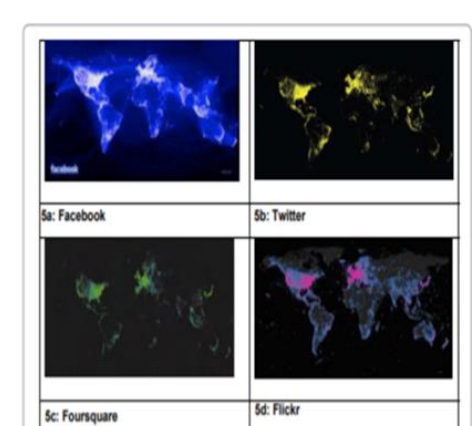
Figure 5: Penetration level of the different social media sources. Note: All pictures represent the penetration level for 2010. Source: Tourism Geography: Emerging Trends